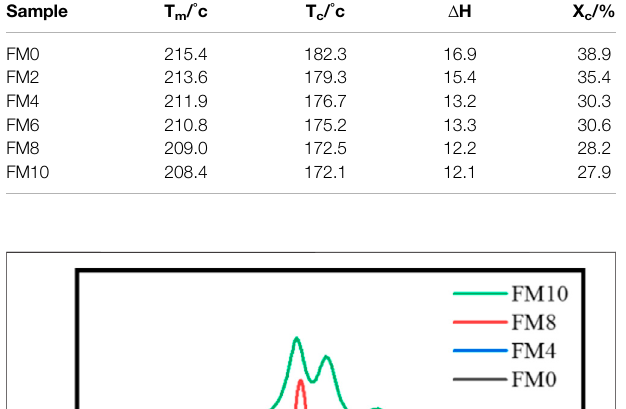
TABLE 4| Thepeak positionofneatPCTFEand PCTFE/FCO inWAXD spectrum.